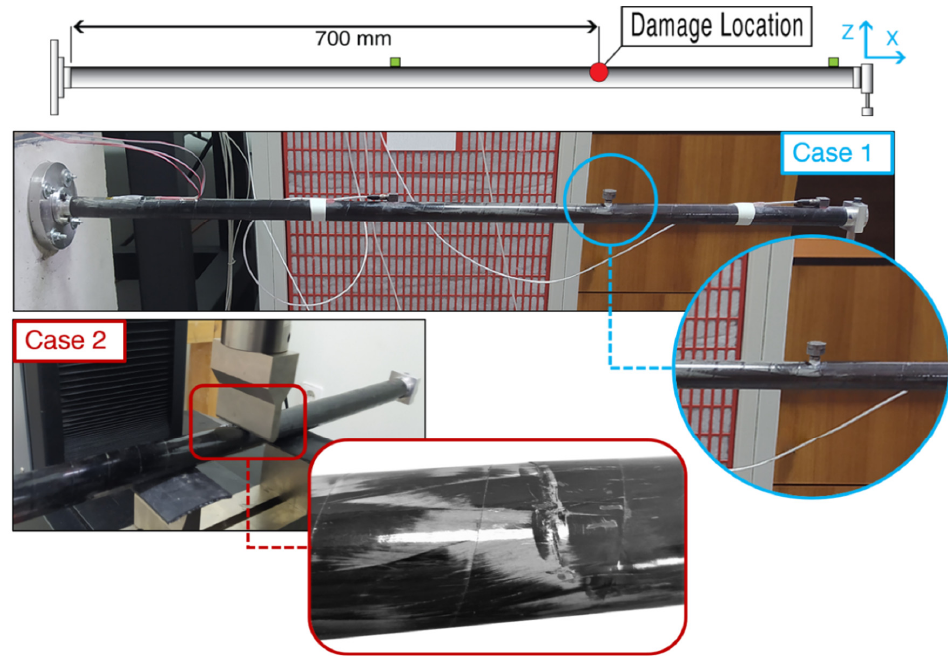
Figure 19. Cantilever CFRP composite beam damage